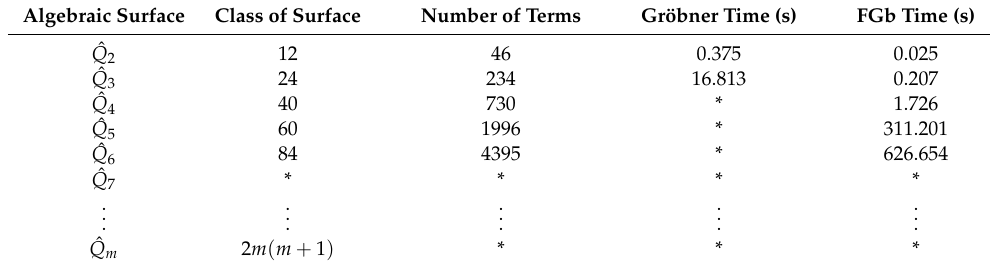
Table 2. Some results of irreducible algebraic surfaces ˆ Q m ( a , b , c ) = 0. Algebraic Surface Class of